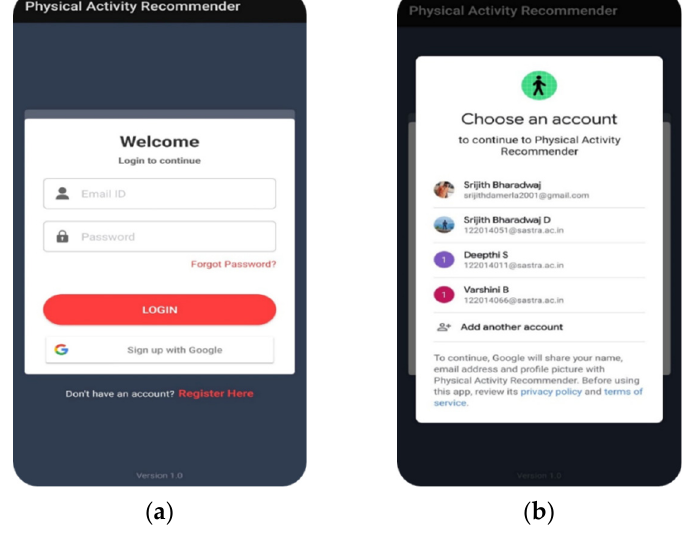
Figure 9. Login page of the android application: ( a ) welcome page with user credentials; ( b ) Google sign-up option for login using user’s Gmail account.